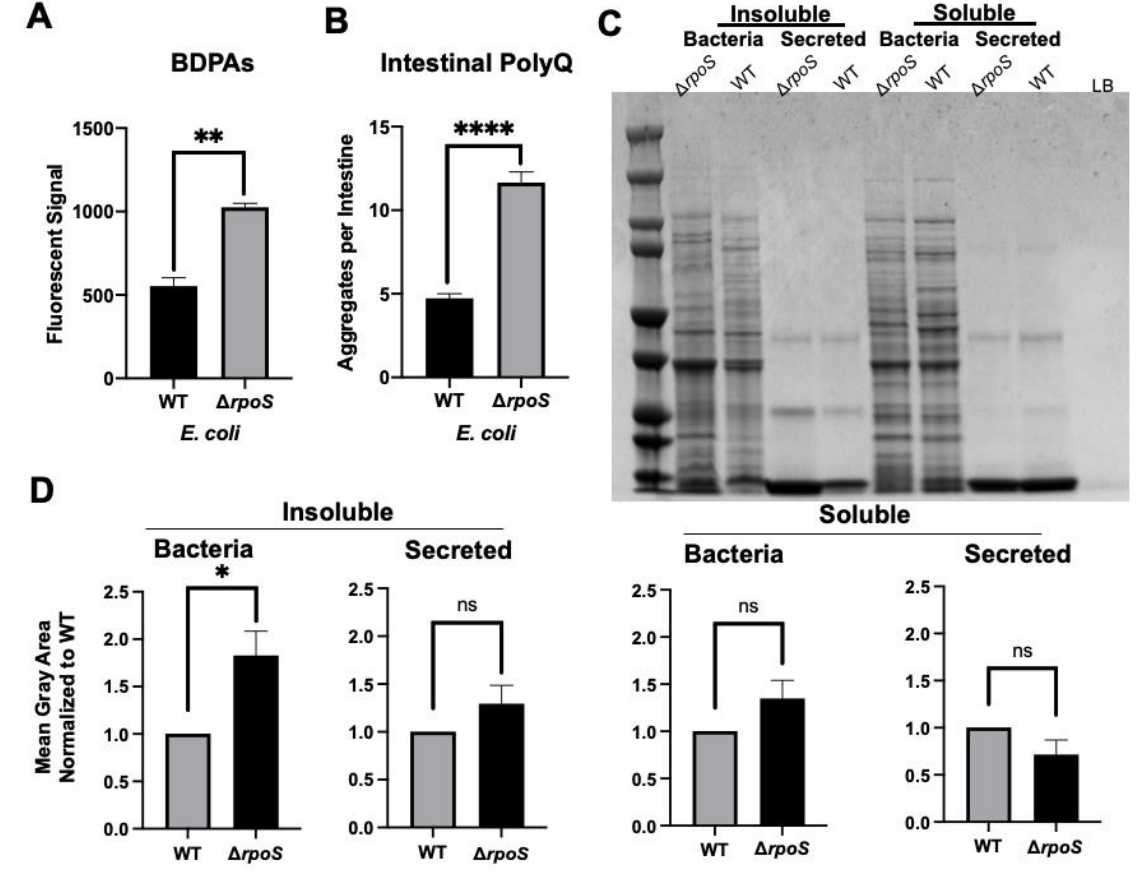
Figure 3. E. coli ∆ rpoS has increased levels of BDPAs and its colonization of the C. elegans